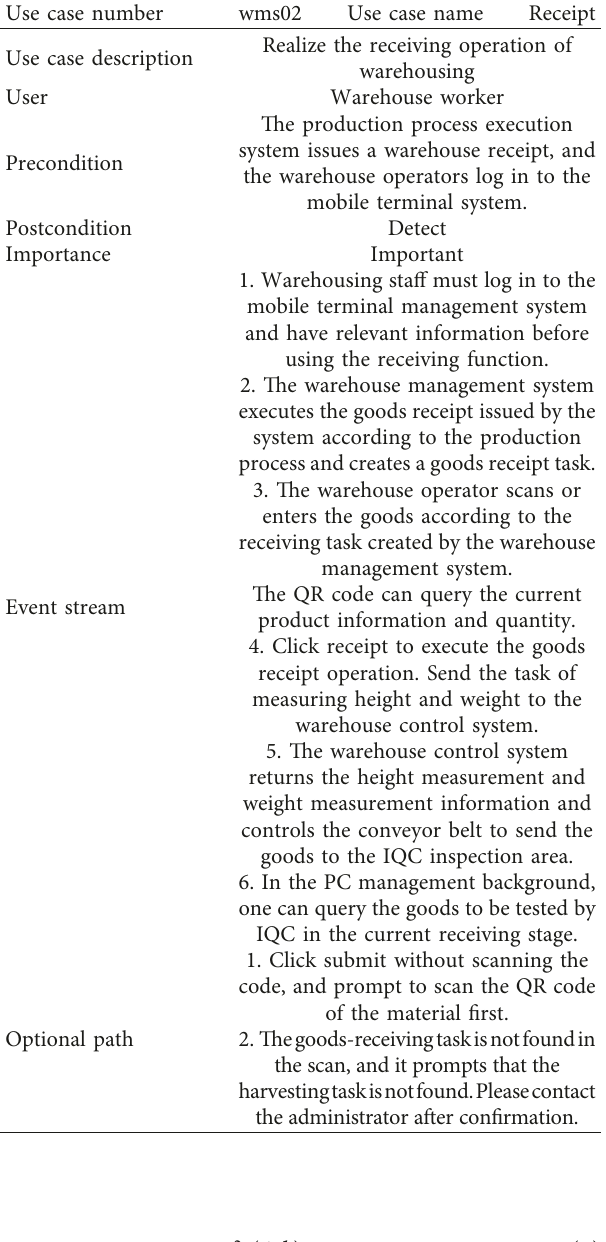
Table 2: Receipt use case